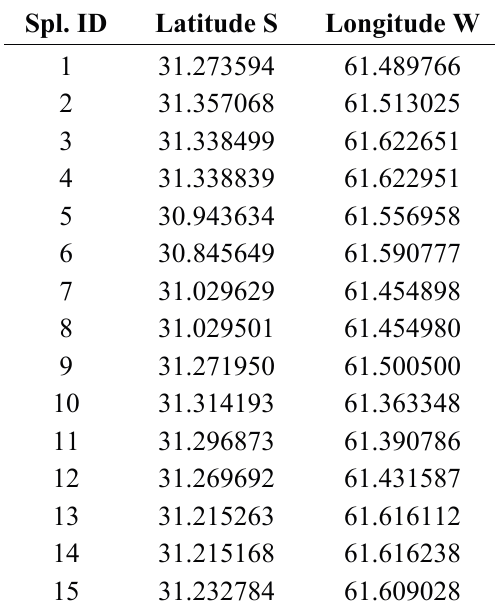
Table A1. GPS location of 15 groundwater sampling sites near Rafaela, Santa Fe province, Argentina (Garmin eTrex 10 GPS device, Garmin, Southampton, U.K.).